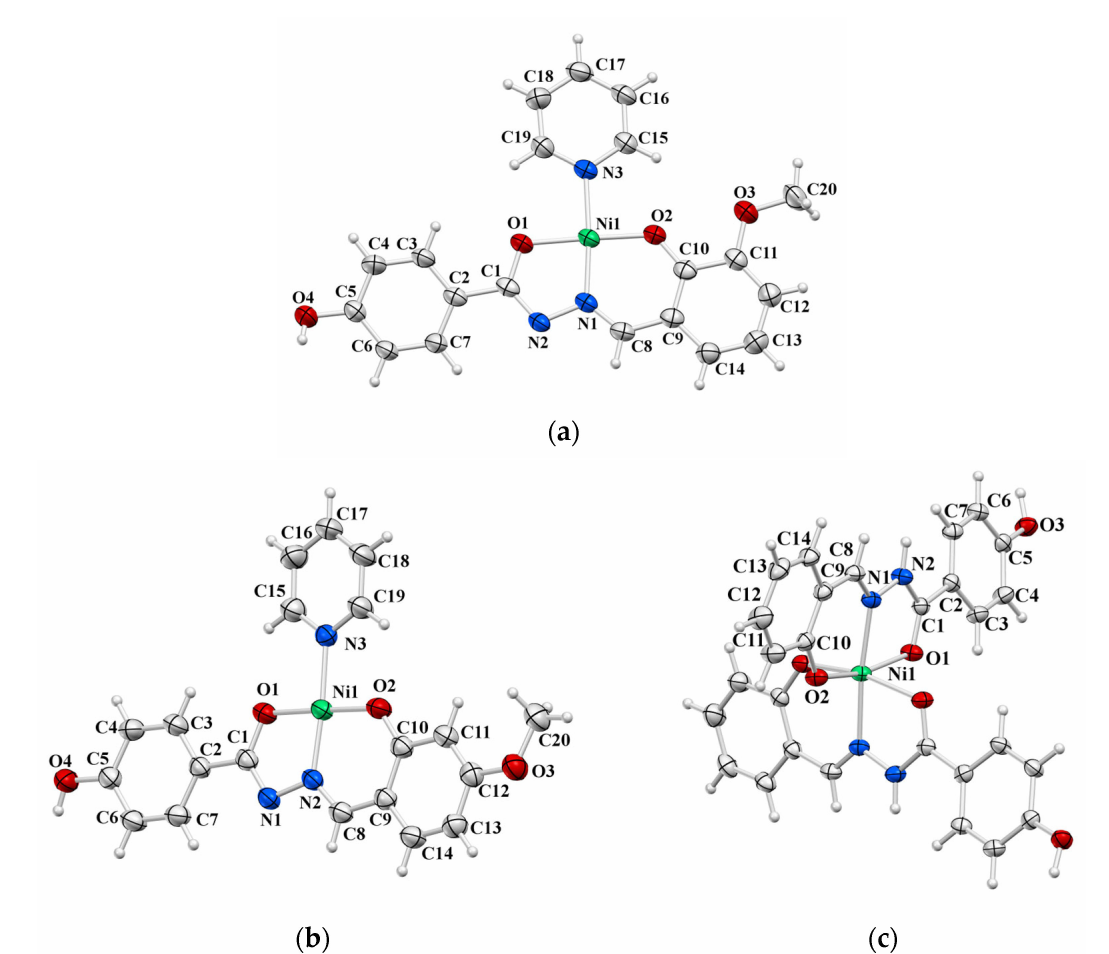
Figure 6. ORTEP view of molecular structures of: ( a ) 4 , ( b ) 5 , and ( c ) 9 · 2MeOH. The displacement ellipsoids are drawn at the 50% probability level at 296(2) K for 4 and 5 , and 150(2) for K 9 · 2MeOH. The MeOH solvent molecules are omitted for